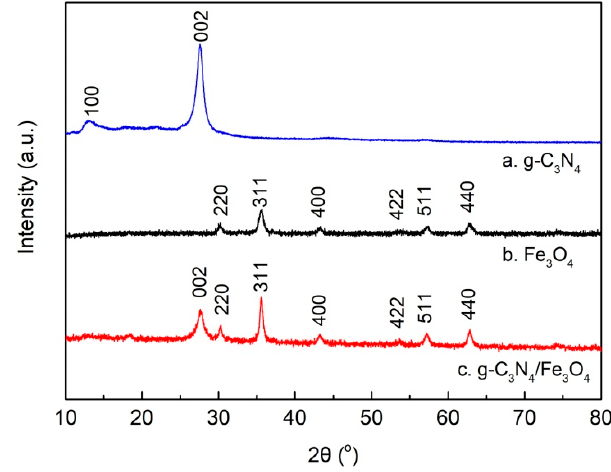
Figure 3. X-ray di ff raction (XRD) patterns of g-C 3 N 4 ( a ), Fe 3 O 4 ( b ), and g-C 3 N 4 / Fe 3 O 4 ( c Figure 3. X-ray diffraction (XRD) patterns of g-C 3 N 4 ( a ), Fe 3 O 4 ( b ), and g-C 3 N 4 /Fe 3 O 4 ( c ).